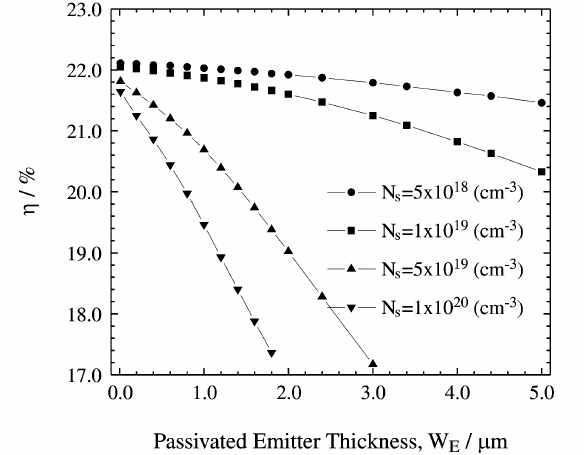
Figure 8. Solar cell efficiency ( η ) as a function of passivated emitter thickness (W E ), considering different doping levels (metal grid shadowing factor F m = 3